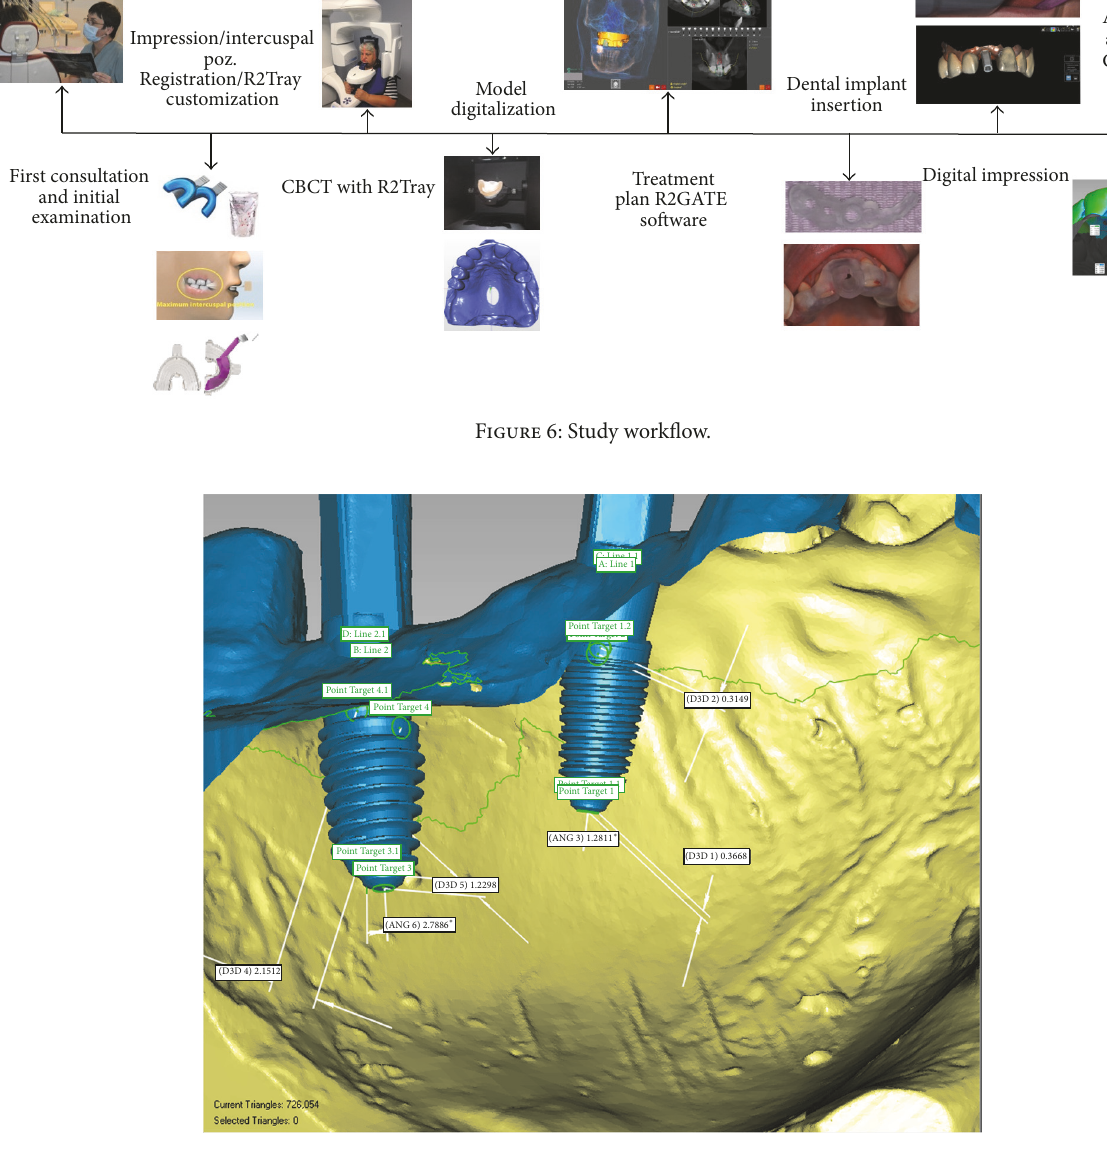
Figure 7: Measurement of 3D accuracy of the planned (reference) and effective implant insertion (test), ∗ represents degree symbol ( ∘ ) as it measures an